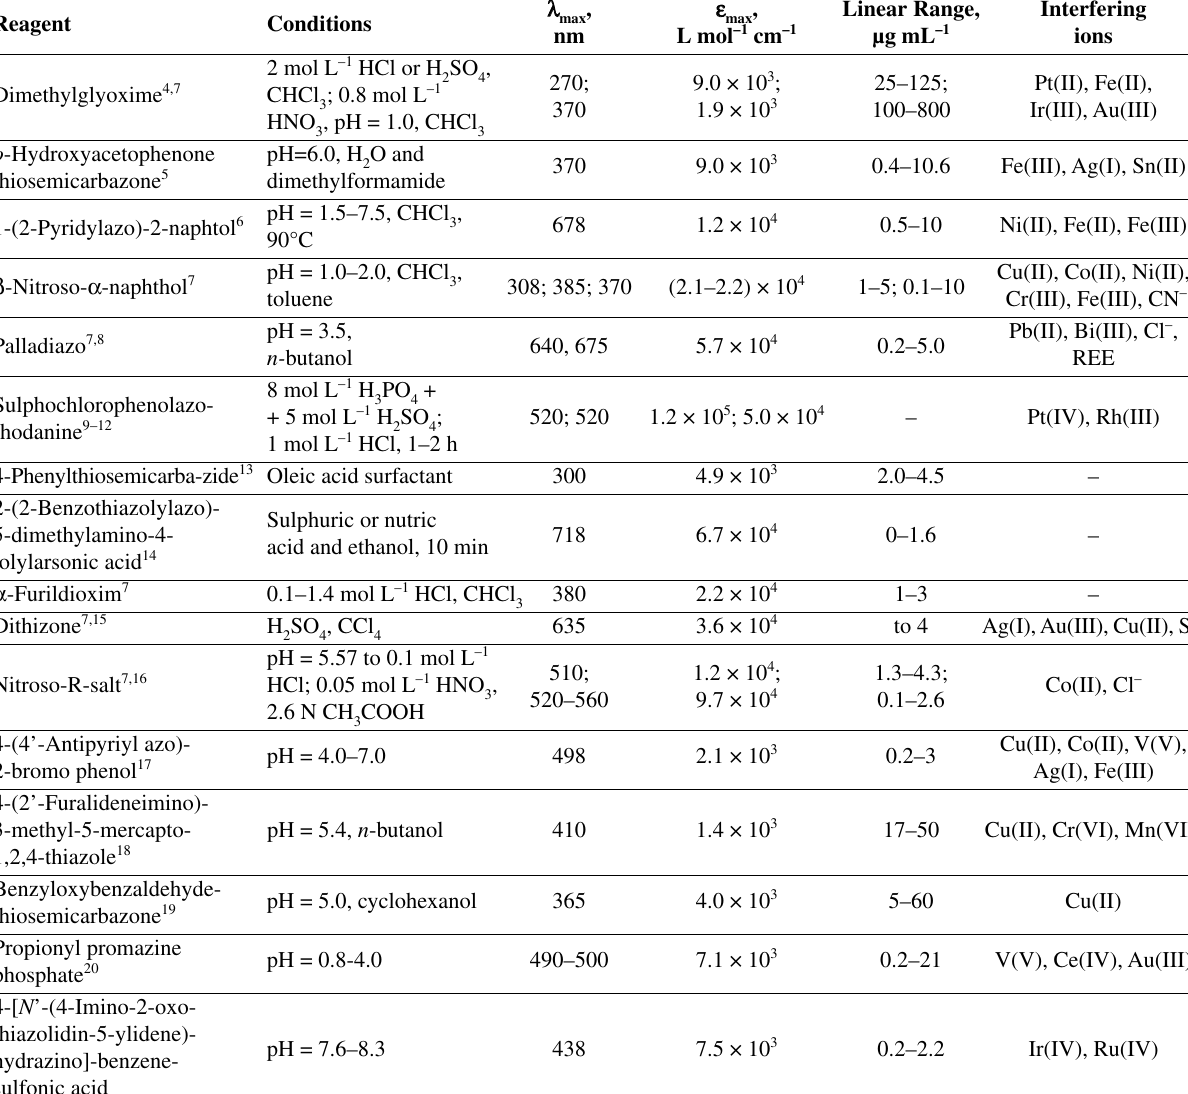
Table 6. Comparison of the present method with other spectrophotometric methods for the determination of palladium(II) Reagent